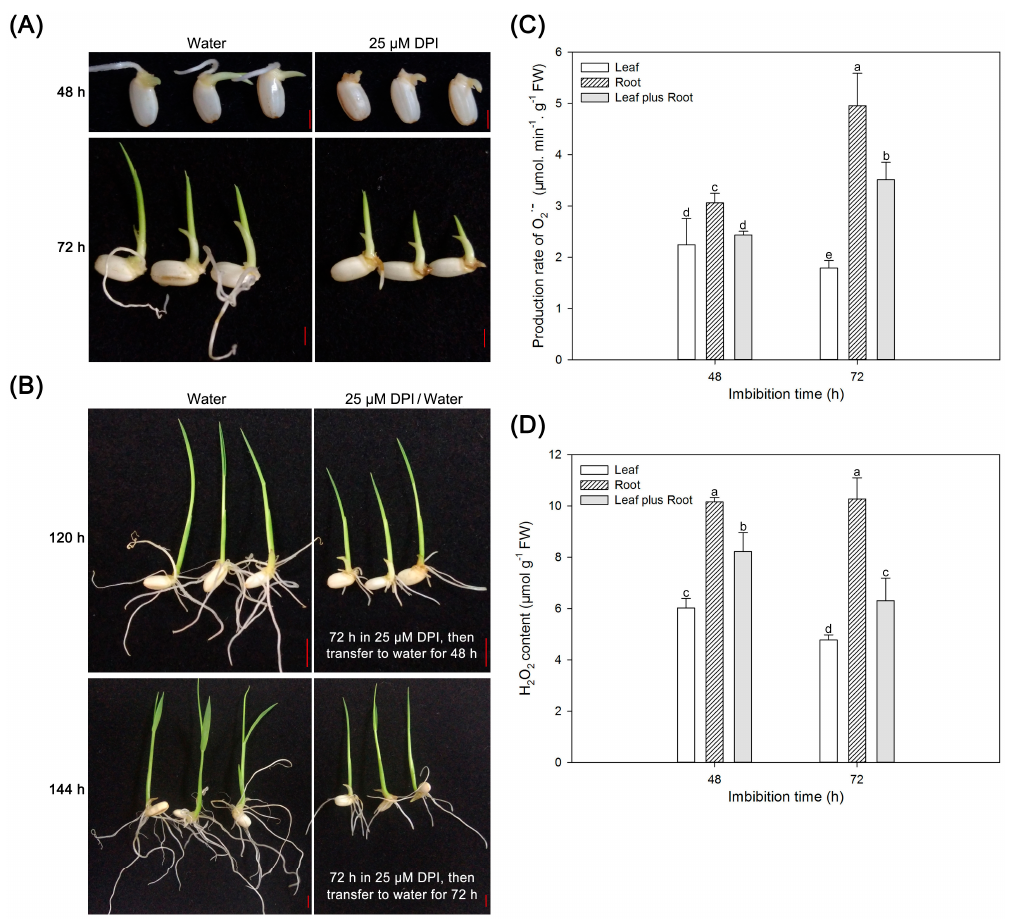
Figure 6. Seedling morphologies and quantification of O 2 ˉ and H 2 O 2 in leaves and root of rice seedlings. ( A ) Morphology of seedlings from rice seeds germinated in water or with 25 μ M DPI for 48 and 72 h. Scale bar, 2000 μ m; ( B ) Morphology of seedlings from rice seeds germinated in water for 120 h ( left , upper ) and 144 h ( left , lower ) or first germinated in the presence of 25 μ M DPI for 72 h and then transferred to water for 48 h ( right , upper ) and 72 h ( right , lower ). Scale bar, 5000 μ m; ( C , D ) Quantification of O 2 ˉ and H 2 O 2 in leaves, root and leaves plus root of rice seedlings incubated in water for 48 and 72 h. Data represent the mean ± SE of three biological replicates of 30 embryos at 48 h and 15 embryos at 72 h (0.2–0.3 g total). Means denoted by the same letter do not significantly differ at p < 0.05 (Fisher’s least significant difference test).